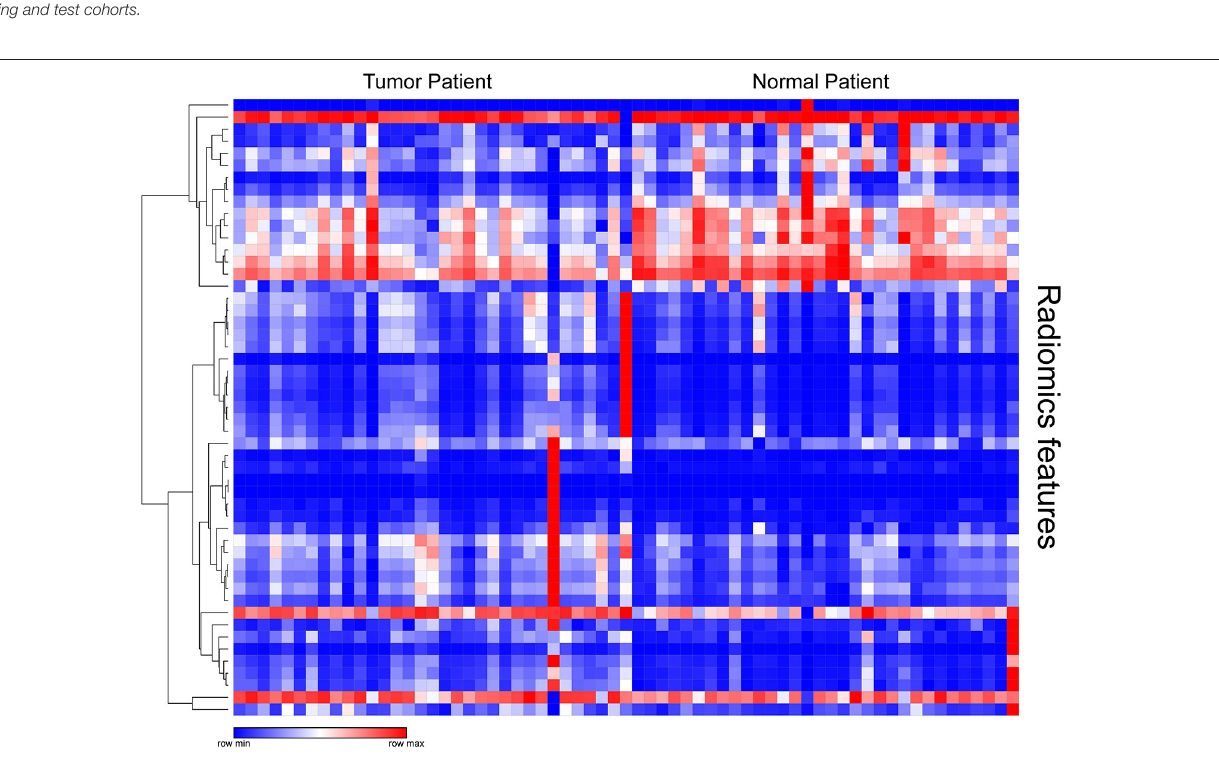
FIGURE 1 | Heat map of texture parameters with differential significance between benign and malignant lesions in the training